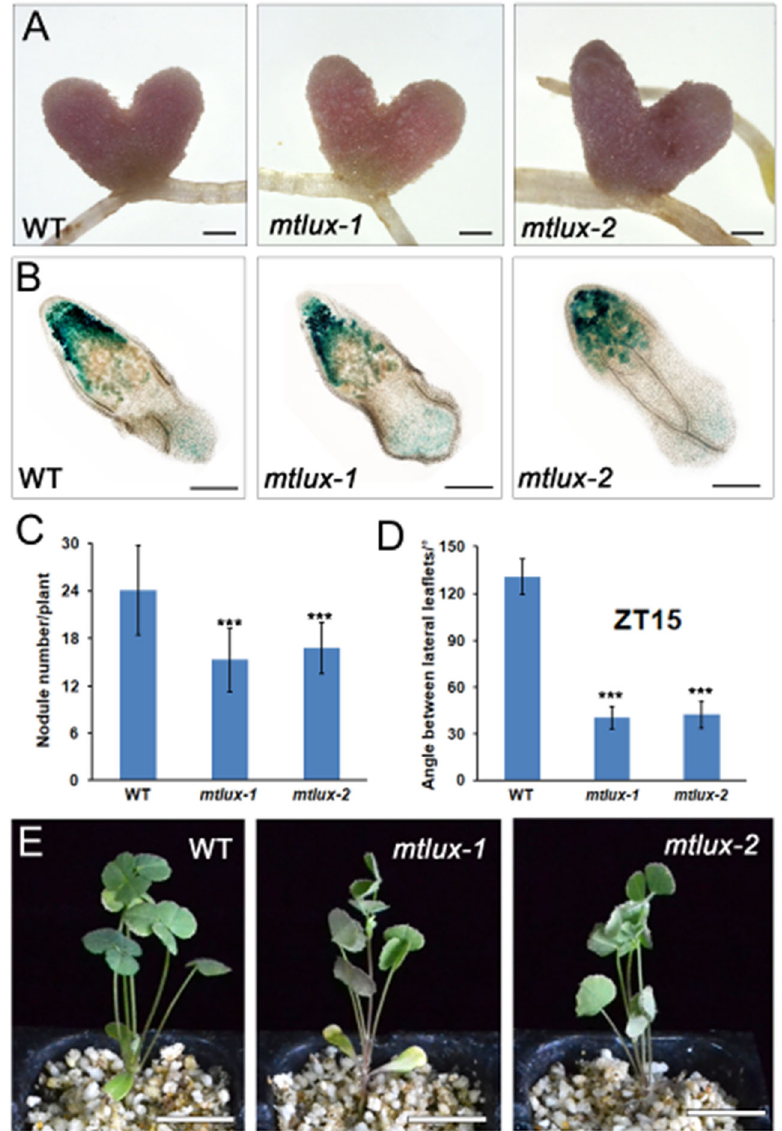
Figure 5. MtLUX gene is involved in nodulation and nyctinastic leaf movement during symbiosis. ( A ) The 21 dpi nodules in wild-type and mtlux plants. Bars = 1 mm. ( B ) The nodules in wild-type and mtlux plants were sliced into sections for β -galactosidase staining. Bars = 1 mm. ( C ) Nodule number in wild-type and mtlux plants counted 21 days after inoculation. Values shown as means ± SD ( n = 20). ***: means differ significantly ( p < 0.001). ( D ) The angle was measured between two lateral leaflets of the first fully expanded trifoliate in 21 days wild-type and mtlux seedlings at ZT15 after inoculation. Values are shown as means ± SD ( n = 15). ( E ) At ZT15, the leaf movement of 21 days wild-type and mtlux plants after inoculation. Bar = 2